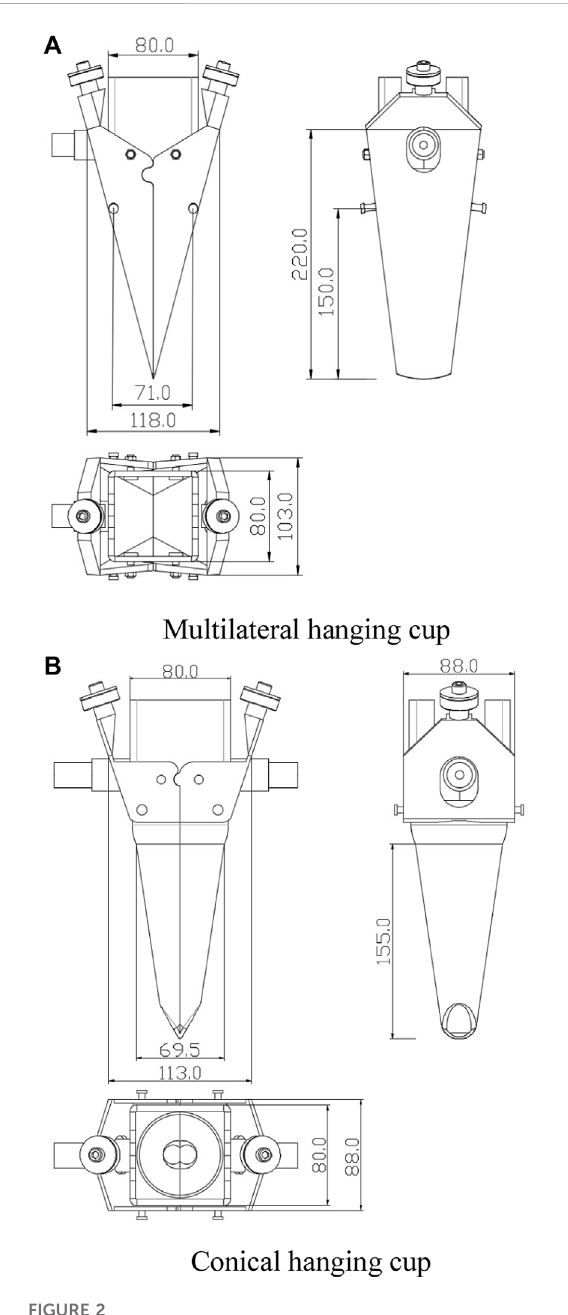
FIGURE 2 Hanging cups of different